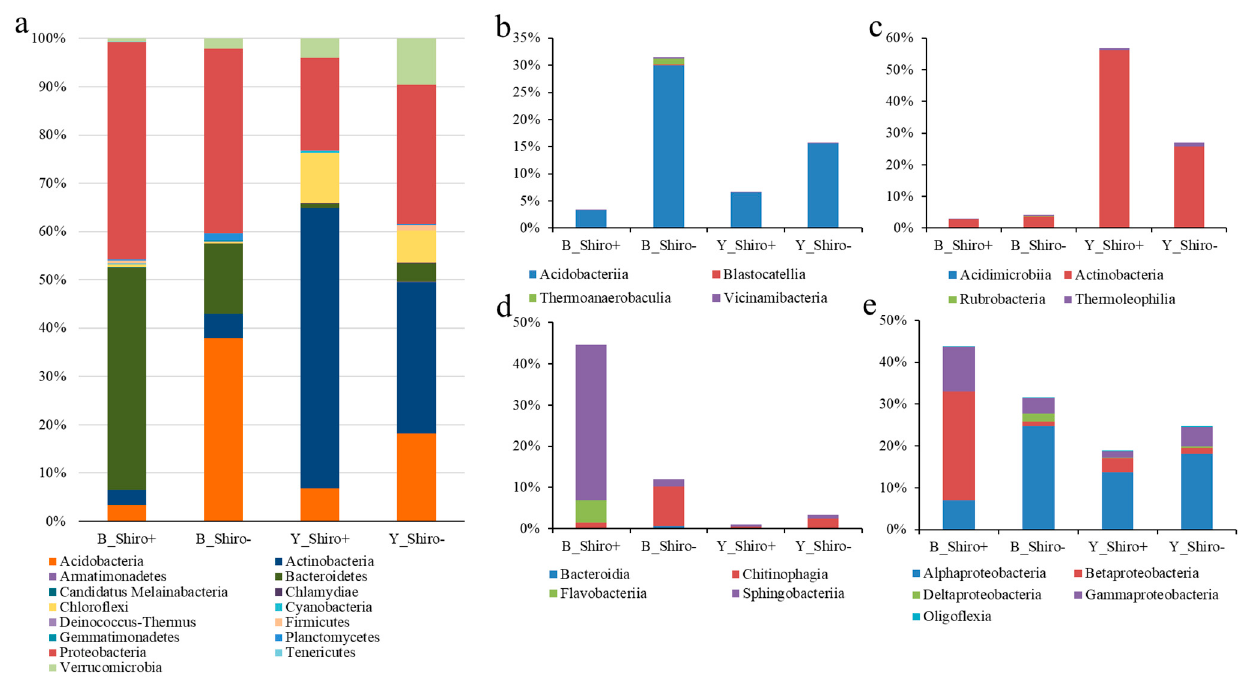
Figure 3. Taxonomic composition analysis of bacterial communities at the phylum level ( a ) and class level ( b – e ) inhibiting the Tricholoma matsutake production (shiro+) and nonproduction (shiro − ) soils of Bonghwa and Yangyang sampling sites. ( b ) four bacterial classes of Acidobacteria phylum, ( c ) 4 bacterial classes of Actinobacteria phylum, ( d ) 4 bacterial classes of Bacteroidetes phylum, and ( e ) 5 bacterial classes of Proteobacteria phylum.